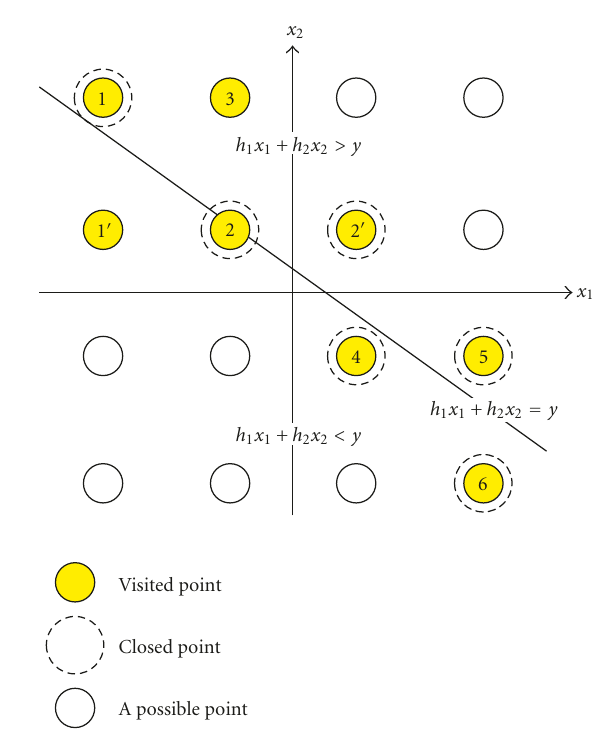
Figure 2: A diagram showing the decoding sequence of planar de-